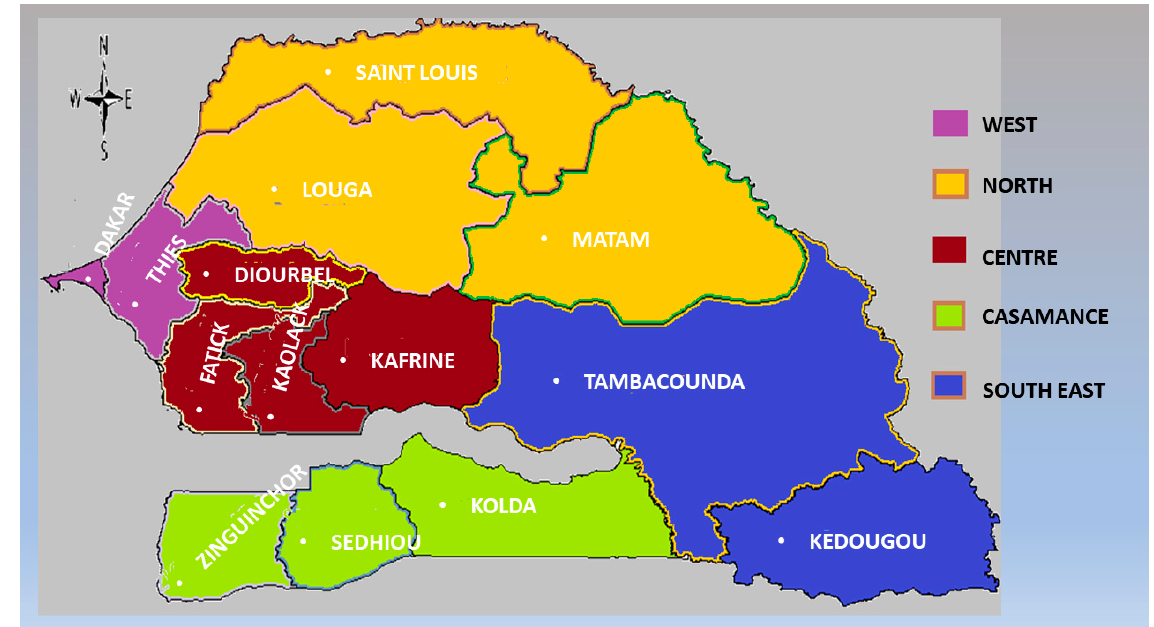
Figure 1. Map of Senegal showing the administrative regions (Source: authors).